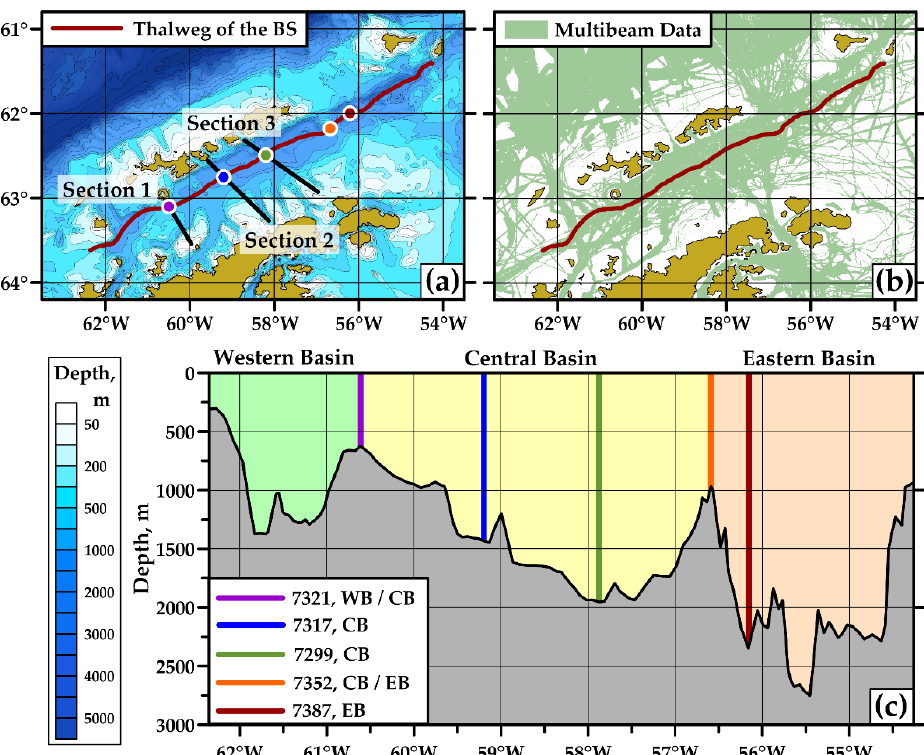
Figure 2. Depths along the thalweg of the Bransfield Strait and location of CTD/LADCP measure- ments. ( a ) Bottom topography according to the GEBCO2021 database, shoreline is based on GSHHS data [17], thalweg is indicated with dark red solid line, CTD/LADCP sections shown with black solid lines, colored dots show the locations of CTD stations along the thalweg presented in ( c ). ( b ) areas with ocean bottom measured with multibeam soundings indicated with green; the data were taken from TID file of GEBCO2021 database. ( c ) Ocean depth along the thalweg of the BS (shown with gray) and location of CTD stations along the strait; the deepest CTD/LADCP station was selected at each transect. Station numbers correspond to Table 1; colors are indicated in the bottom